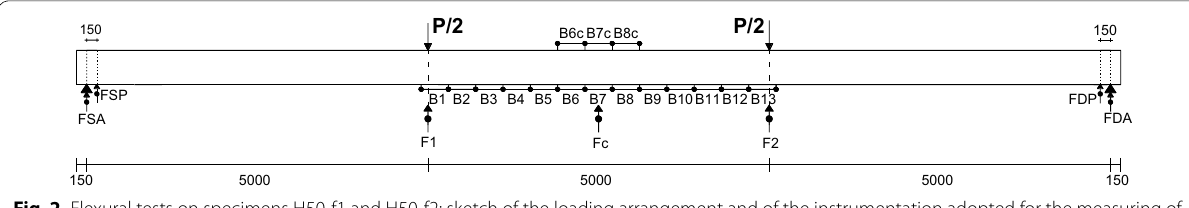
Fig. 2 Flexural tests on specimens H50-f1 and H50-f2: sketch of the loading arrangement and of the instrumentation adopted for the measuring of strains and vertical displacements (dimensions in